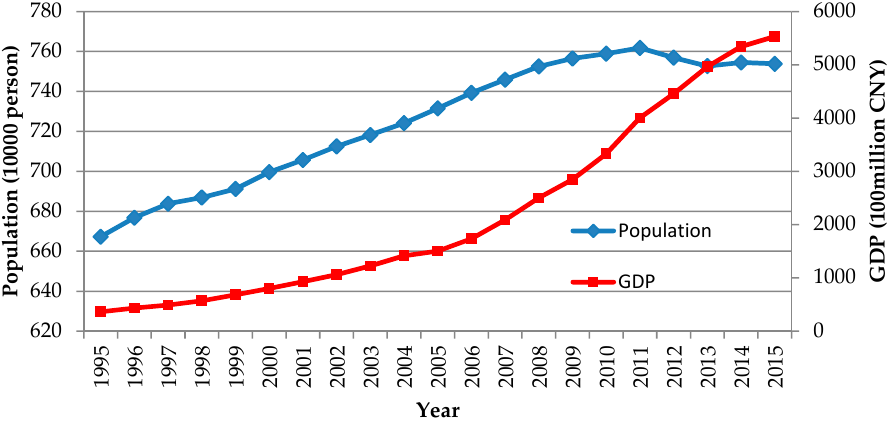
Figure 7. GDP and population of Changchun (1995–2015).